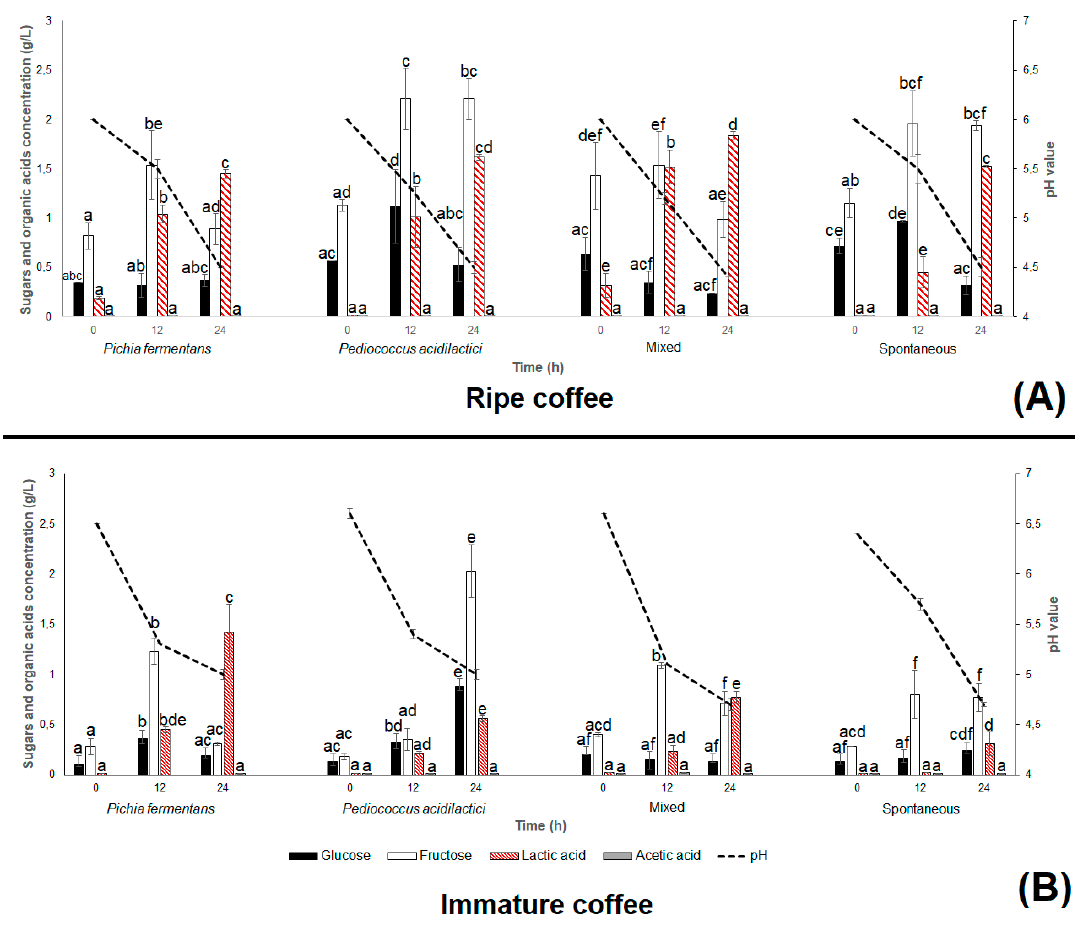
Figure 1. Pulp sugar consumption, organic acid production, and pH monitoring of inoculated (pure culture with Pichia fermentans , pure culture with Pediococcus acidilactici , and combined fermentation with P. fermentans and P. acidilactici ) and spontaneous fermentation of ripe (A) and immature (B) coffee fruits. The significance of the results was assessed using an ANOVA with Duncan’s post-hoc test at p < 0.05. Different lowercase letters (a, b, c, d, e, f) indicate significant differences within the same process (ripe and immature coffee beans) over fermentation time.